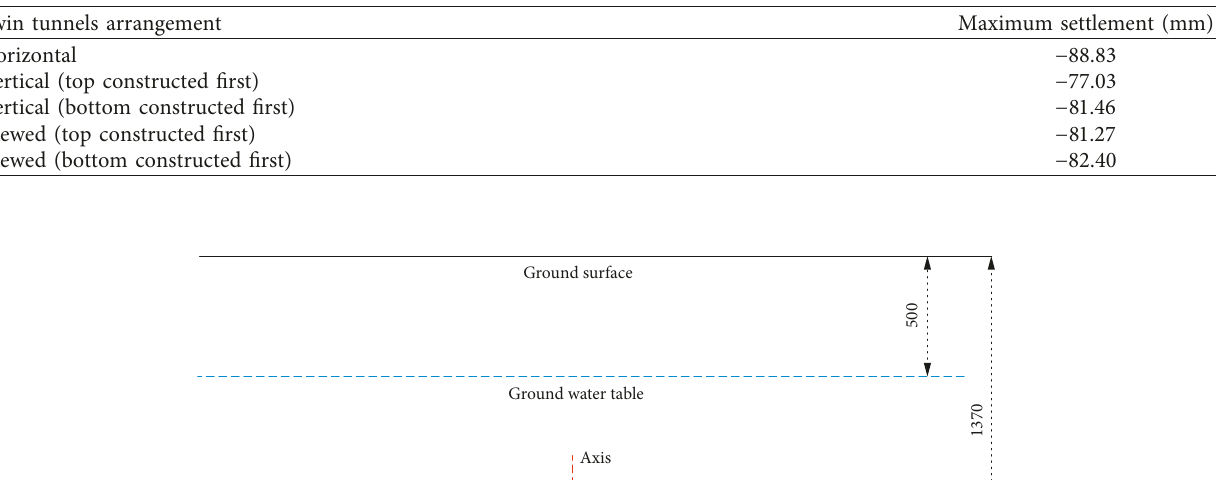
Table 5: Maximum settlements resulting from different twin